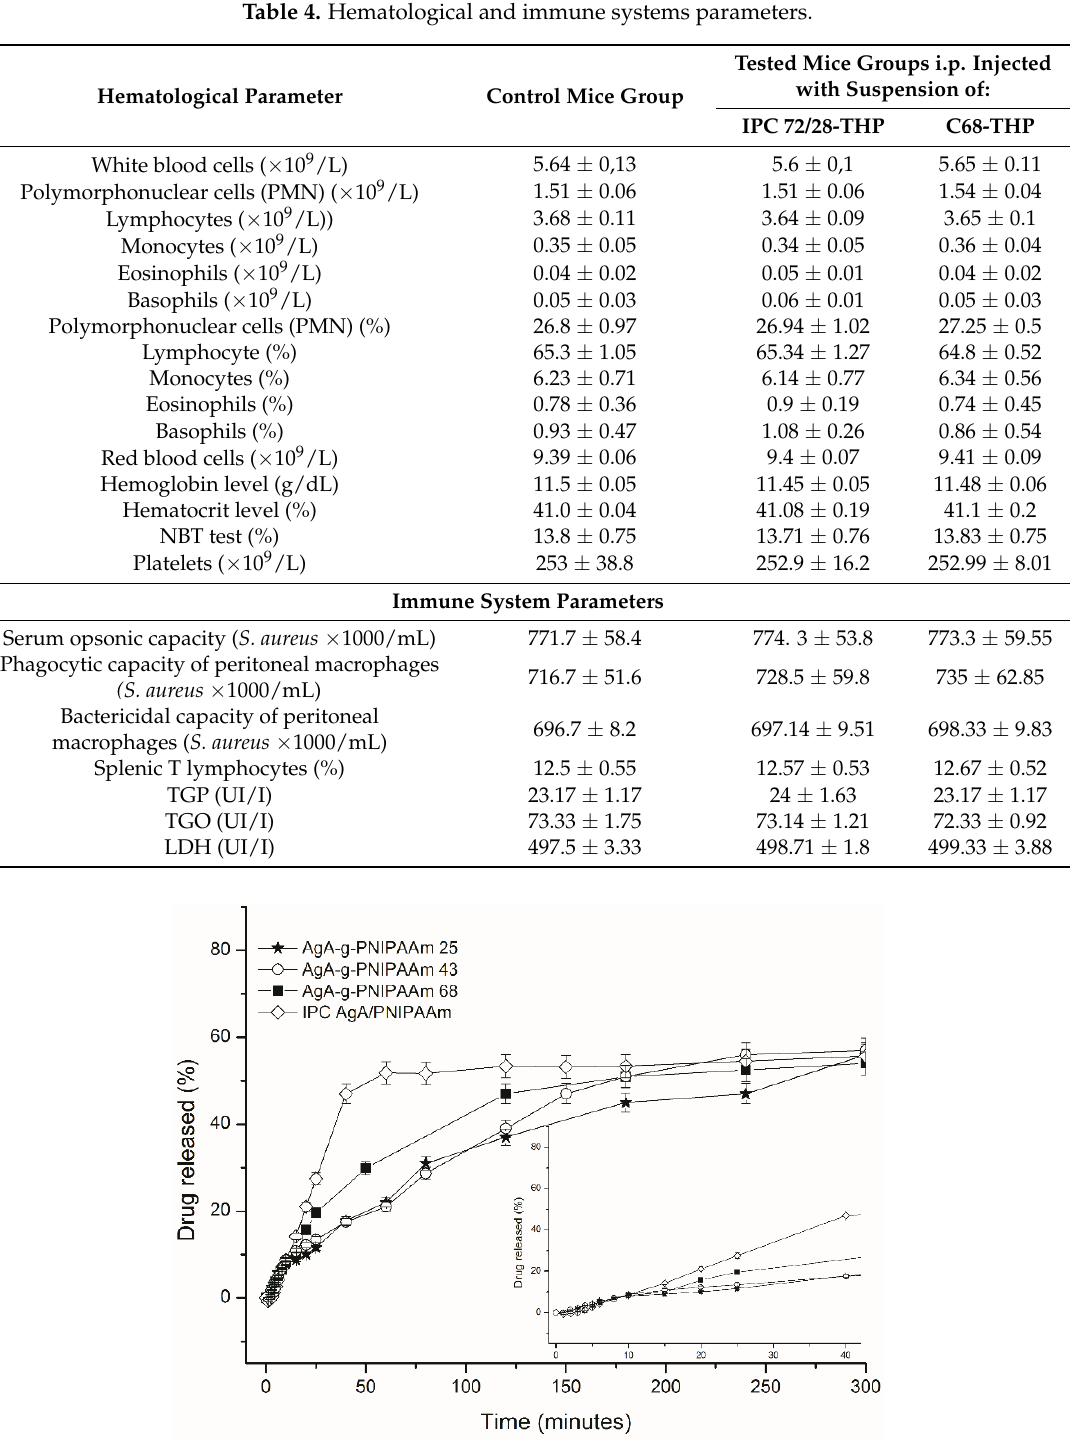
Figure 5. In vitro release profiles of theophylline from matrices constituted from IPC 72/28 and C25, C43 and C68 graft copolymers.